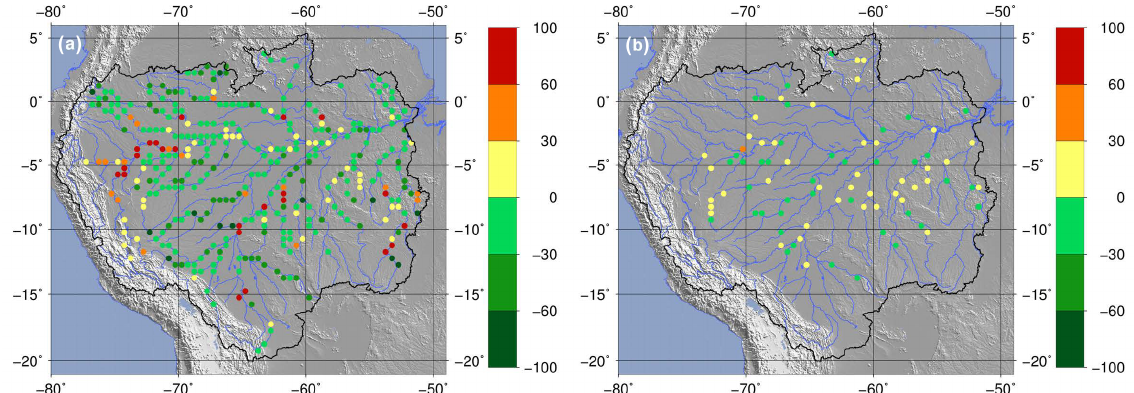
Figure 13. Analysis RMSEn differences between SE1-local and SE3-local experiments with respect to (a) the ENVISAT discharge and (b) gauge discharge.